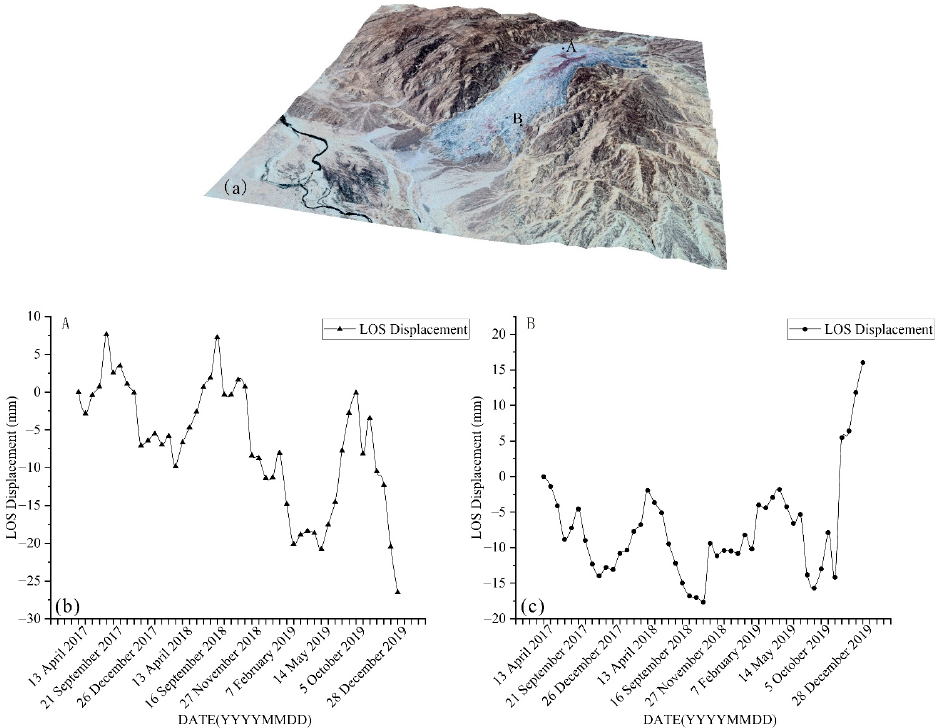
Figure 8. ( a ) The location of Points A and B; ( b ) the time series displacement for Point A; and ( c ) the time series displacement for Point B.